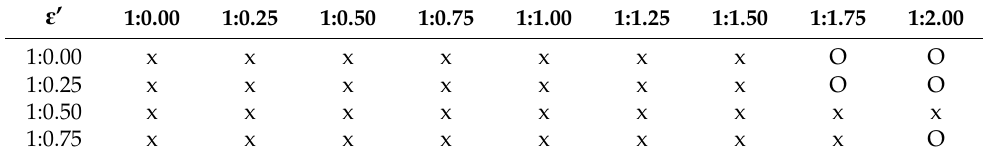
x Table A7. Significant difference in conductivity between various Slacker concentrated groups. A significant difference was indicated with O and an insignificant difference was indicated with x.